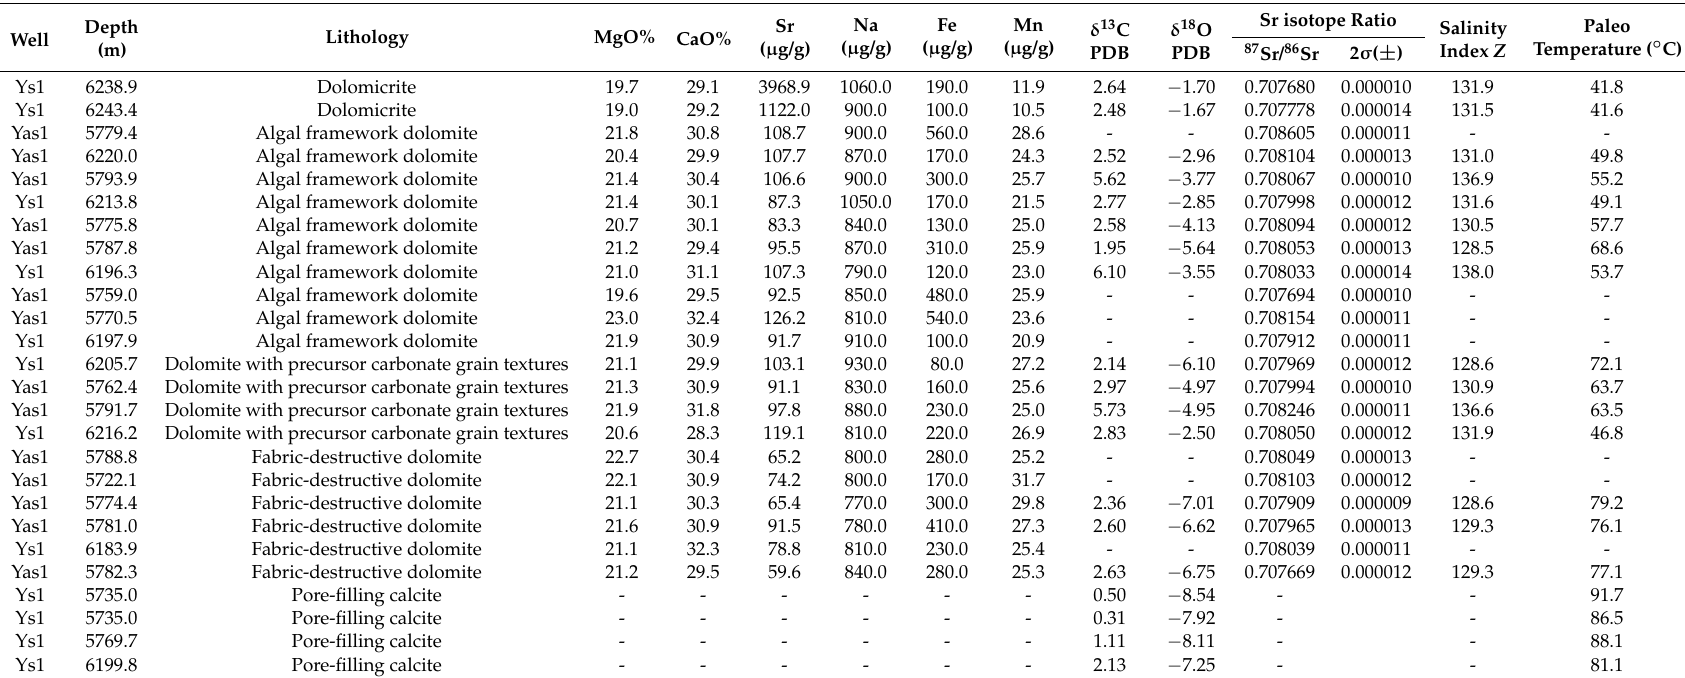
Table 1. Stable isotope compositions, major and trace elemental concentrations of dolomite samples in the Leikoupo Formation, Western Sichuan